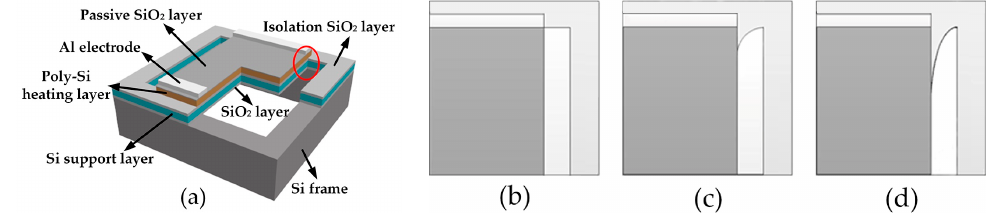
Figure 1. ( a ) Structure design of bridge-style Si-based micro-electromechanical systems (MEMS) infrared (IR) emitter with sectional views in hotplates, and partial enlarged top-views for ( b ) square fillet (SF); ( c ) circular fillet (CF); and ( d ) oval fillet (OF).